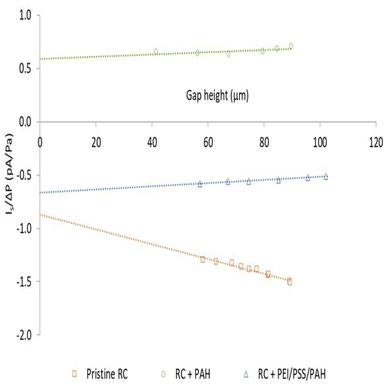
Streaming current coefficient (Is/ΔP) of the unmodified, PAH modified and PEI/PSS/PAH modified RC membranes versus gap height; Solution: 0.001 M KCl at pH 5.40 ± 0.05.